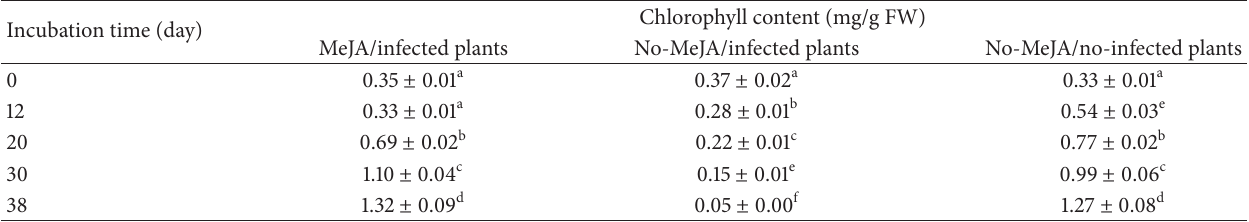
FOV: Fusarium oxysporum f. sp. vasinfectum ; FW: fresh weight; leaves were treated with 5.0mM of MeJA, inoculated at 72h (day 0) with FOV, and incubated at 25 ∘ C for 38 days. data are expressed as mean of three replicates; within row and column, numbers followed by a different letter are significantly different according to Duncan’s multiple range test at P = 0.05 level; MeJA: methyl